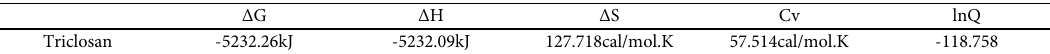
Fig. 5. IR spectrum of triclosan by B3LYP/6-311++G(2d,2p) Table 2. Thermodynamic parameters of triclosan by